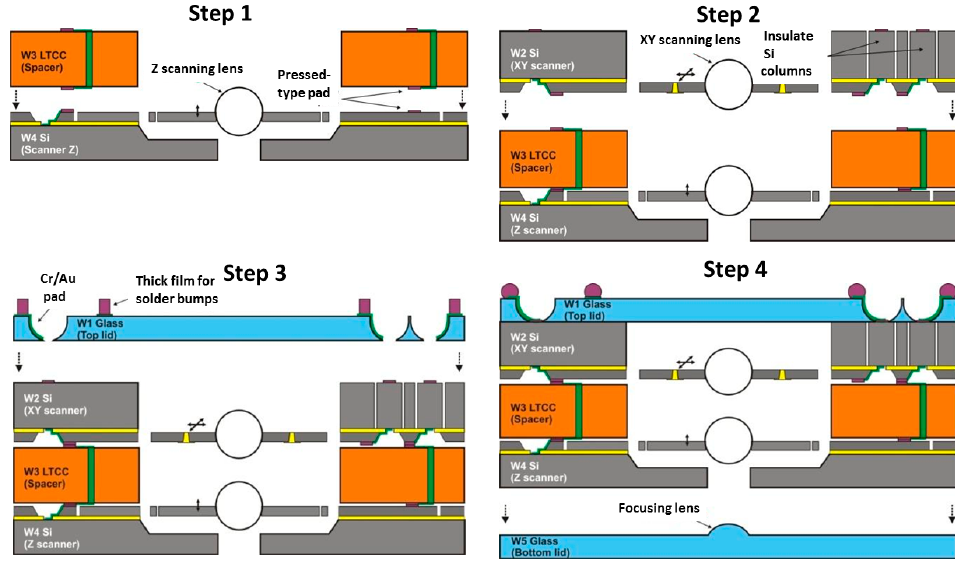
Figure 21. Assembly of 3D microscanner by sequence of anodic bonding processes.